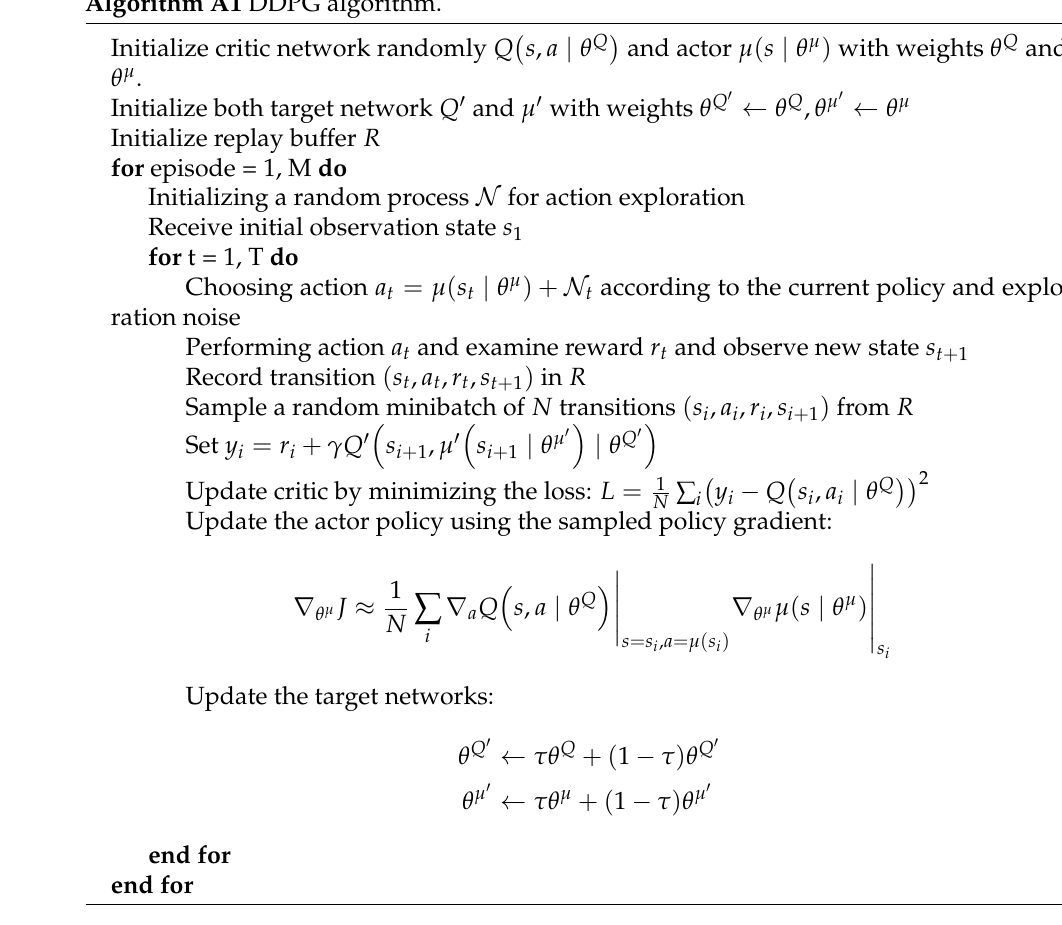
Algorithm A1 DDPG algorithm.